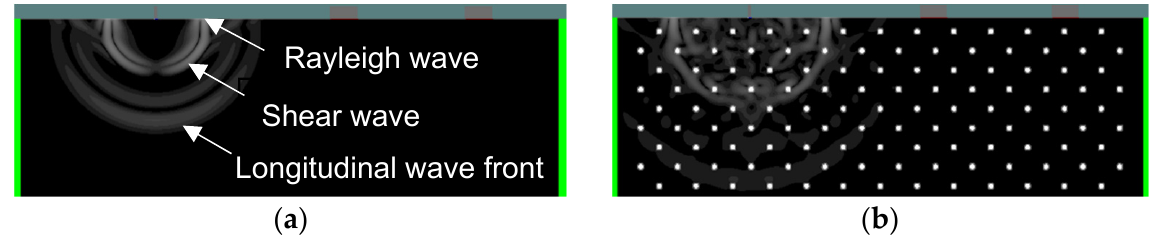
Figure 4. Displacement field close to the surface of ( a ) mortar without voids and ( b ) mortar with 3% voids a few µ s after excitation.